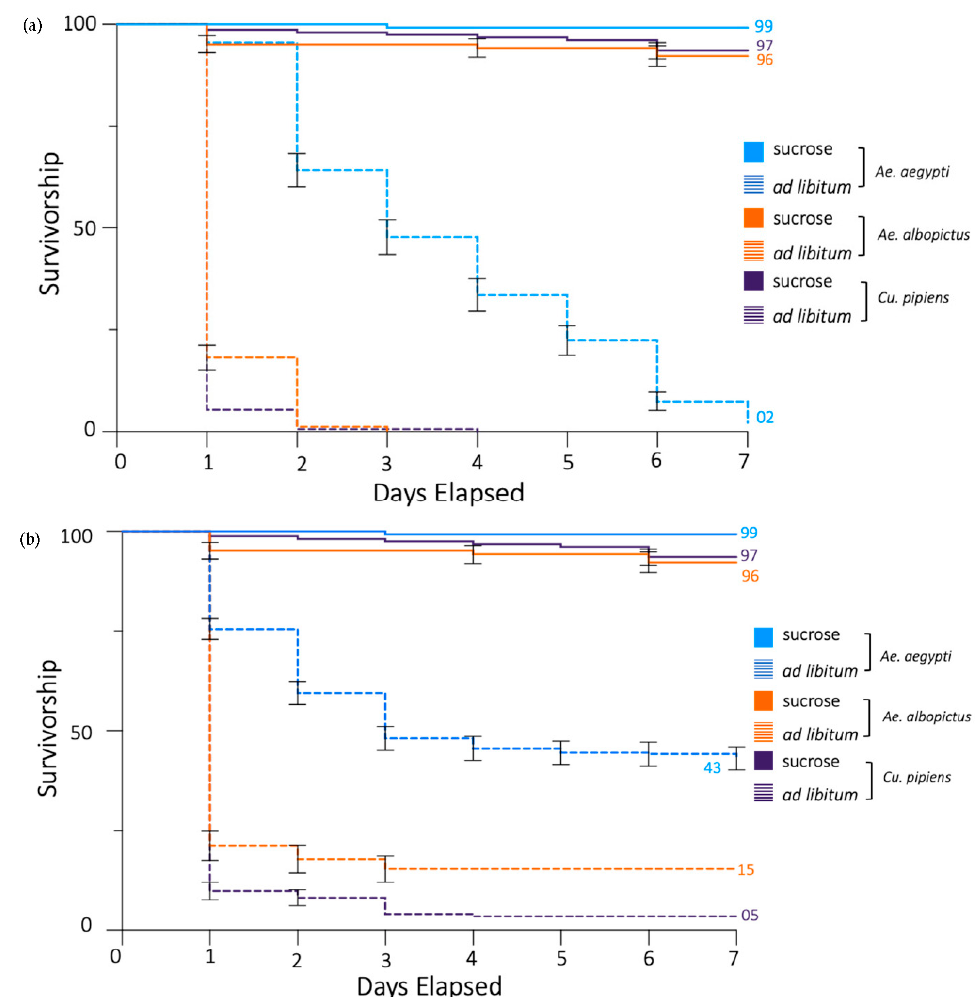
Figure 3. Propylene glycol reduces the daily survivorship of Ae. aegypti, Ae. albopictus, and Cx. pipiens mosquitoes. ( a ) A Kaplan–Meier curve demonstrates the decline in mosquito survivorship over the course of 7 days. Populations fed on 5% sucrose or 5% sucrose + 5% propylene glycol ad libitum. Percentage of the population surviving on day 7 is provided when applicable. Error bars indicate SE of the mean. ( b ) Populations fed on 5% sucrose ad libitum or 5% sucrose + 5% propylene glycol for 24 h, at which point it was replaced with 5% sucrose. Percentage of the population surviving at day 7 is provided when applicable. Error bars indicate SE of the mean.